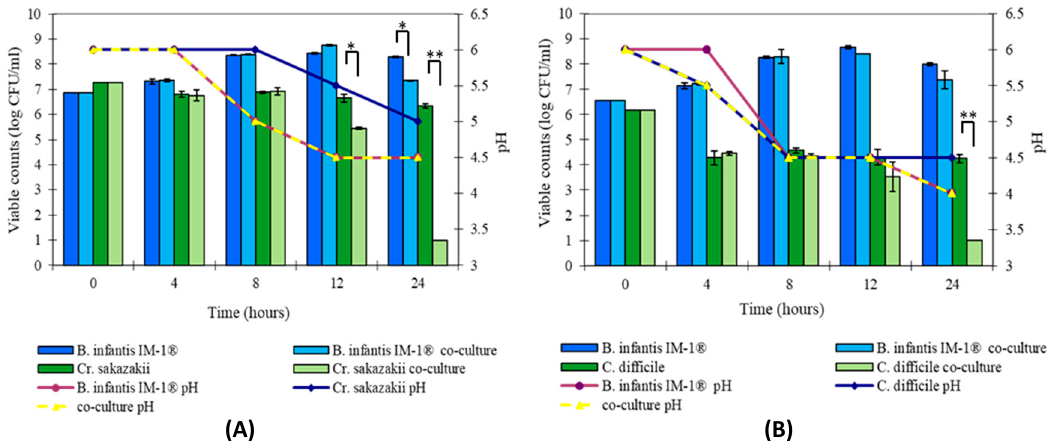
Figure 3. Evolution of microbial counts (log CFU/mL) and pH values in single and co-cultures of probiotic strain B. infantis IM-1 ® and enteropathogens: ( A ) Cr. sakazakii and ( B ) C. difficile . For each pathogen–bifidobacteria combination, the statistical significance of counts between co-culture and single culture (control) was calculated using Student’s t -test (* p < 0.001, ** p < 0.0001).